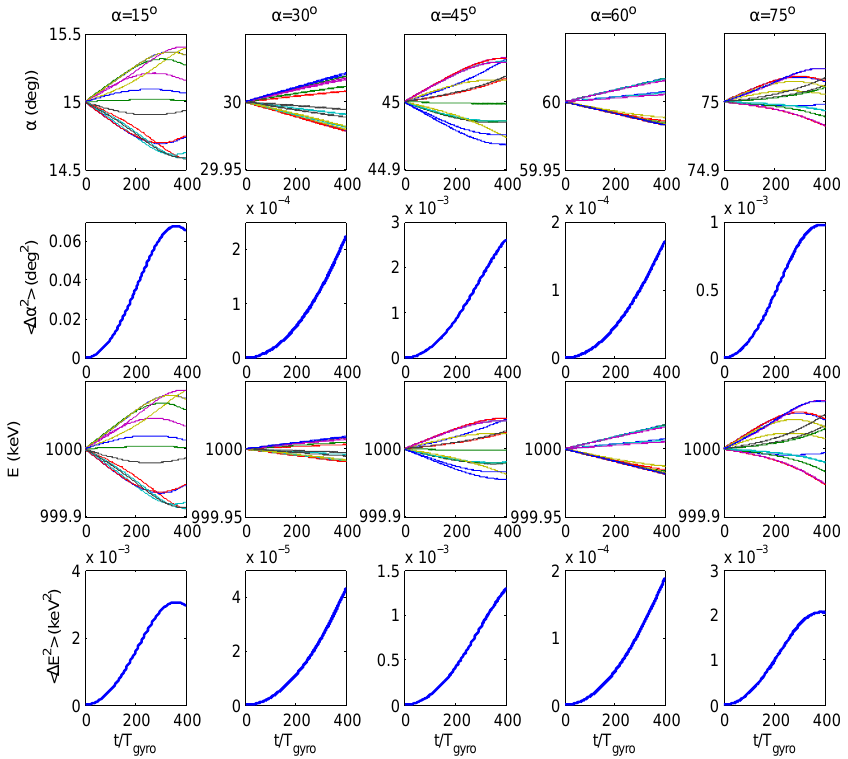
Figure 8. Results of resonant diffusion of 1MeV electrons having five initial pitch angles, from left to right, 15 ◦ , 30 ◦ , 45 ◦ , 60 ◦ , and 75 ◦ , for the N = 1 resonance: changes of pitch angle (first row) and kinetic energy (third row) of 15 randomly selected electrons, and 1α 2 (second row) and 1 E 2 (fourth row) averaged over all 200 electrons. The wave-normal angle is fixed as 100 ◦ , but the wave frequencies vary with initial electron pitch angle to satisfy the N = 1 resonance